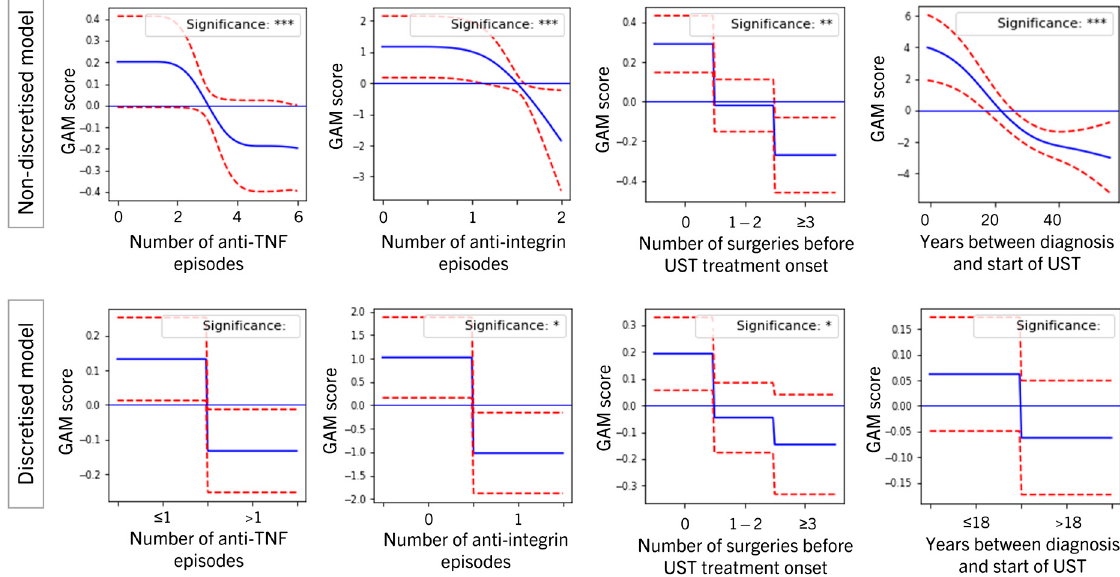
Figure 3. Generalized additive model (GAM) plots showing estimated effects of selected significant variables in the longitudinal remission model, in the non-discretized model ( top row ) and discretized model ( bottom row ). Plots may be read by comparing one value on the x -axis to another and can be read off as the vertical distance between the respective y -values. Horizontal blue line denotates 0 (no effect), solid blue line represents the estimated effect of different values of the covariates and discontinuous red lines represent 95% confidence intervals. * p < 0.05, ** p < 0.01, *** p < 0.001.